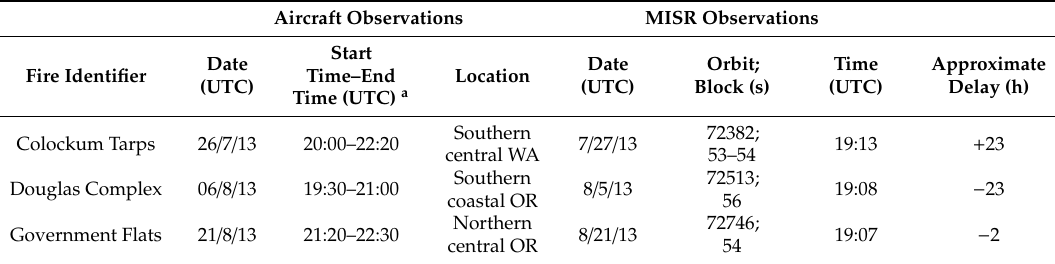
Table 1. Flight dates, times, and locations compared with dates and times of the Multi-Angle Imaging Spectroradiometer (MISR) overpass of the same area. Positive time delays between satellite and aircraft observations indicate the satellite observed the fire after the aircraft, whereas negative numbers mean the satellite completed its overpass first. The last flight, on 21 August, is the focus of the validation portion of the study. UTC—Universal Coordinated